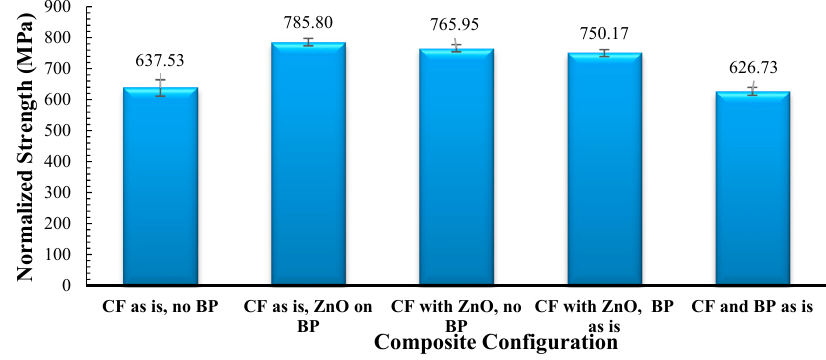
Figure 5. Comparison of normalized strength for the different composites configurations.